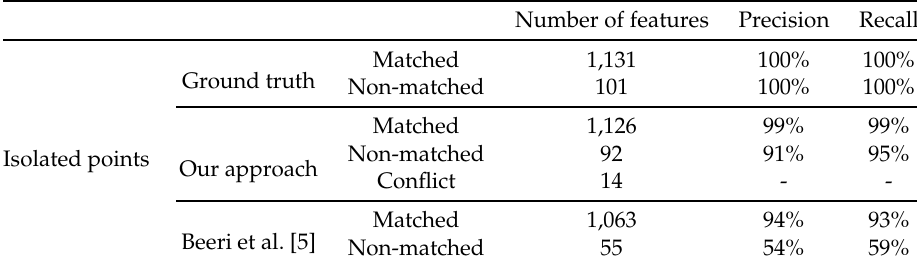
Table 1: Qualitative evaluation of results for isolated